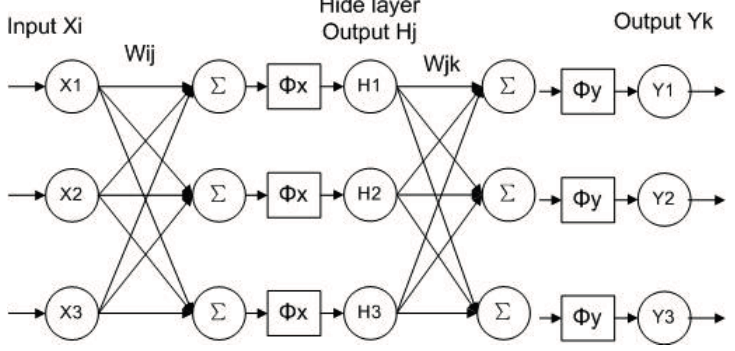
Figure 4. Structure of three-layer BP neural